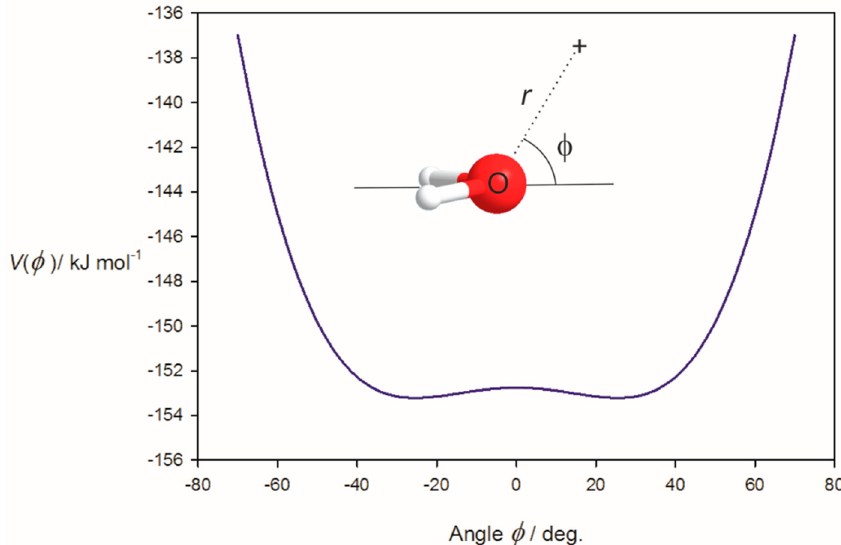
Figure 1. Variation of the electrostatic potential V ( φ ) with the angle φ at distance r from the O atom in H 2 O. The angle φ is that made by r with the C 2 axis of the molecule. H 2 O. The angle φ is that made by r with the C 2 axis of the